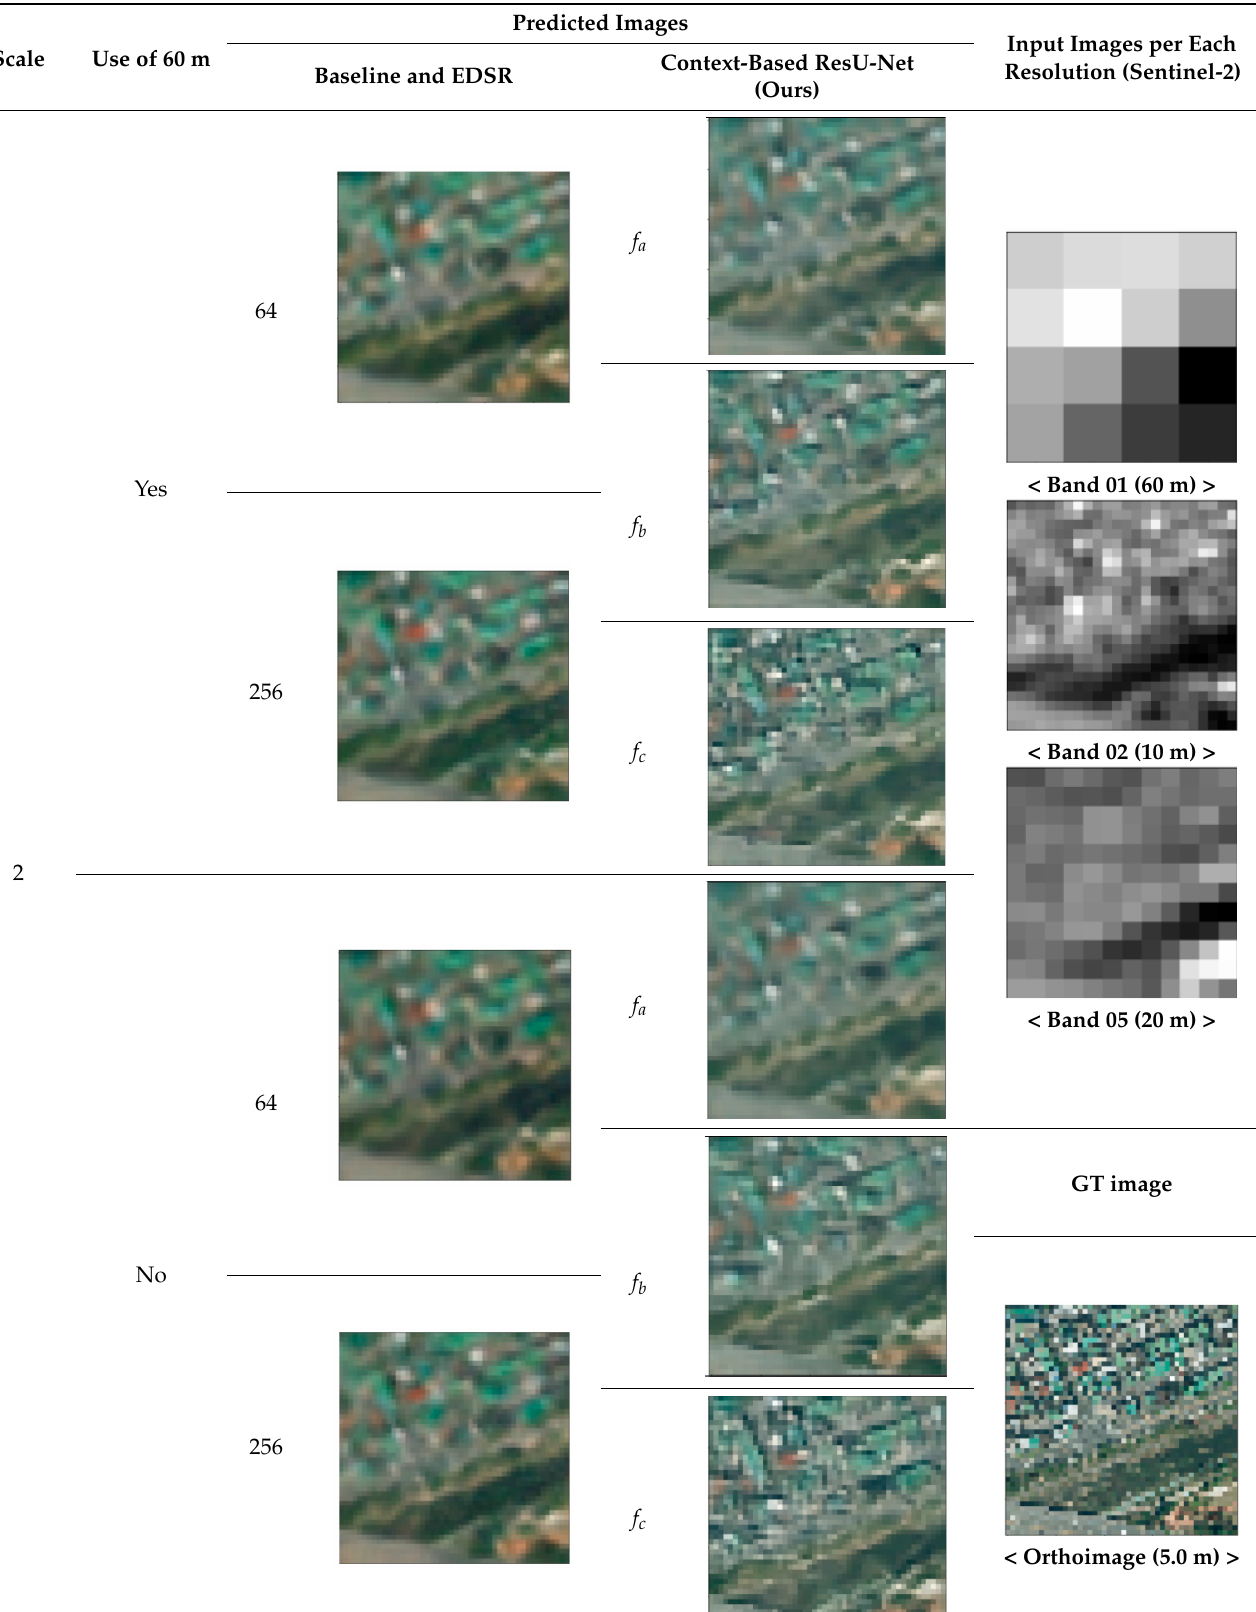
Table 6. Predicted images of Sentinel-2 and corresponding GT image (urban